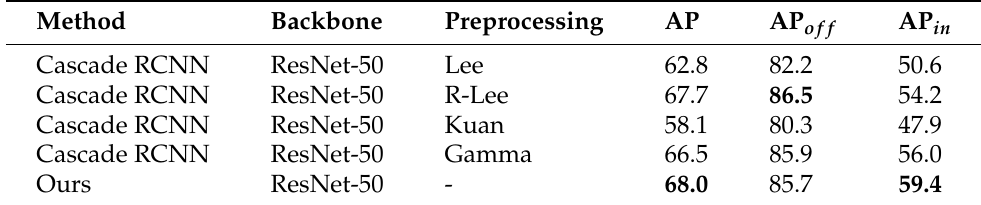
Table 8. Comparison with baseline methods (dataset was preprocessed using traditional